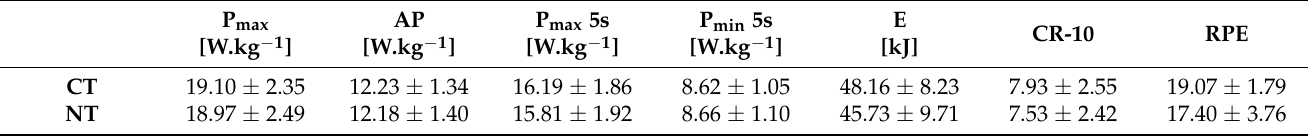
Table 2. Wingate test and perceived pain results (mean ±